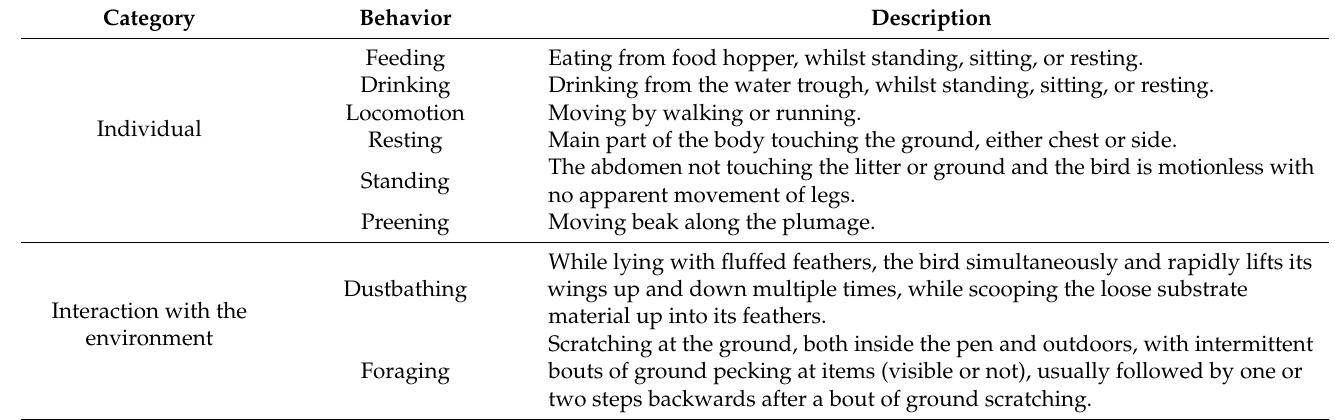
Table 1. Ethogram of mutually exclusive